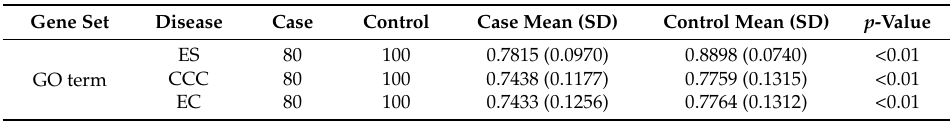
Table 1. Sample number and mean of the gene set regularity indices for each group. SD: standard deviation.